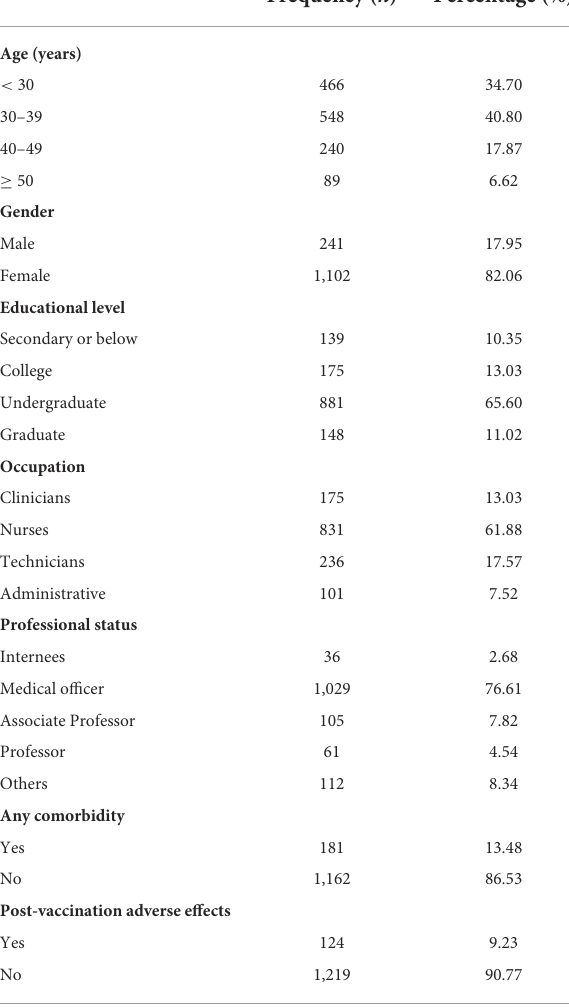
TABLE 2 Baseline demographics of study participants ( n = 1,343). TABLE 3 Univariate analysis of baseline characteristics of participants and willingness to take the booster shot against COVID-19